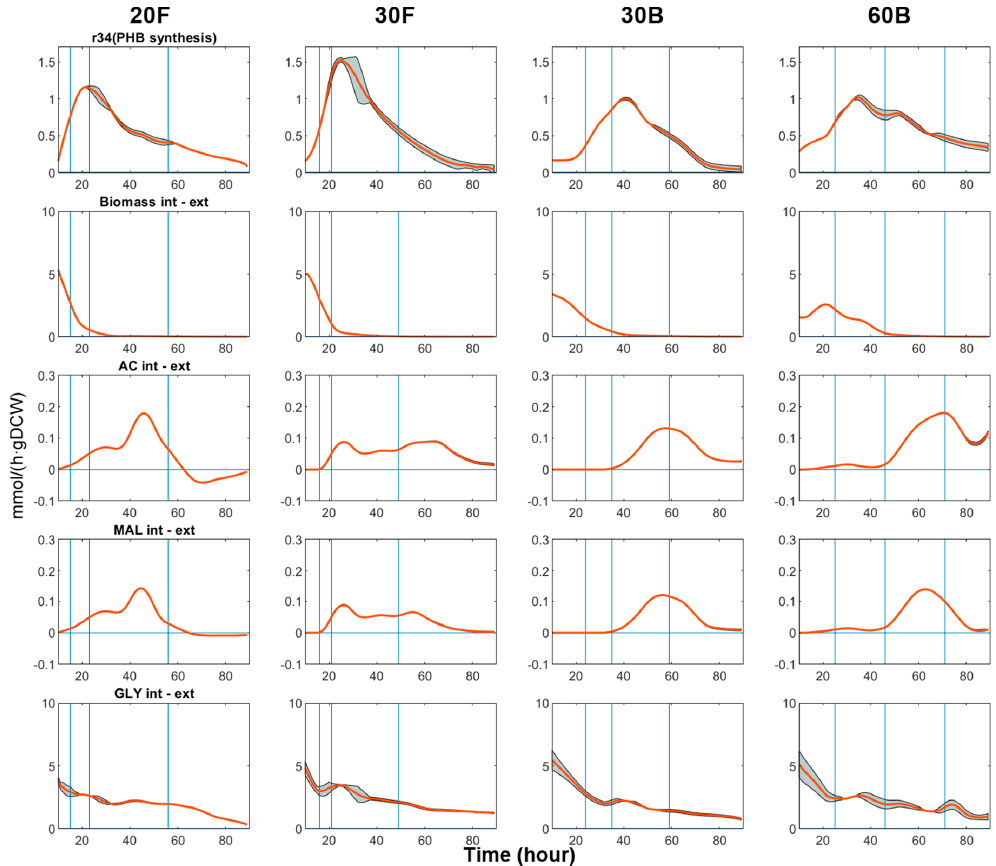
Figure 5. Flux profiles for glycerol (GLY) uptake, biomass synthesis and products (PHB, acetic acid (AC) and malic acid (MAL)) synthesis. Time range: 10–90 h.